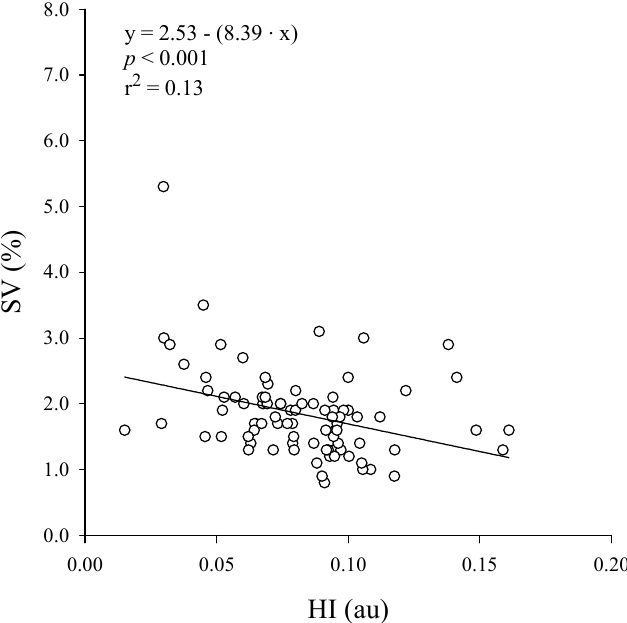
Figure 4. Correlation between Stride Variability (SV) and Harmony Index (HI).